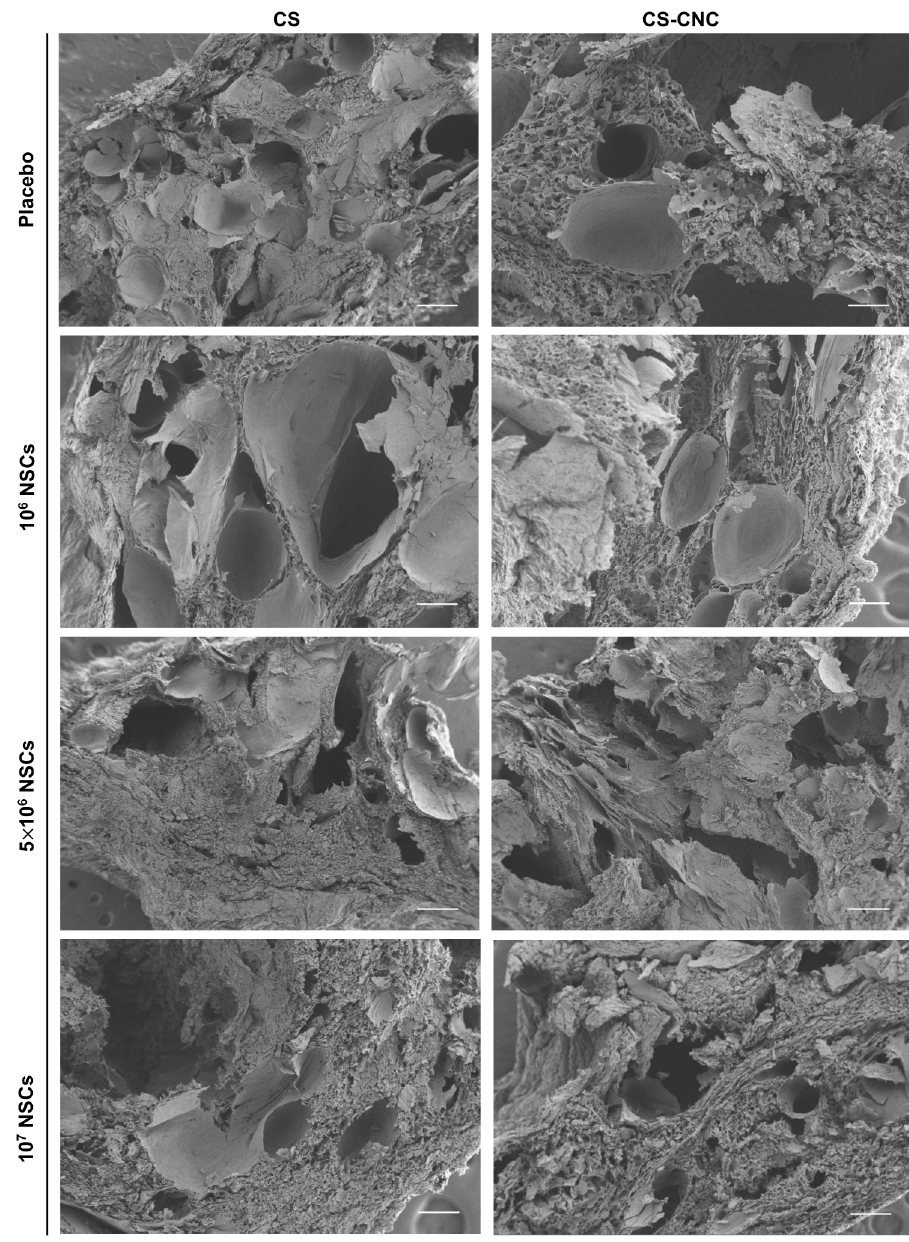
Figure 4. Effect of NSCs on scaffold microstructure using Scanning Electron Microscopy. SEM images of hydrogels post 24-h incubation in DMEM (scale bar, 100 μ m).